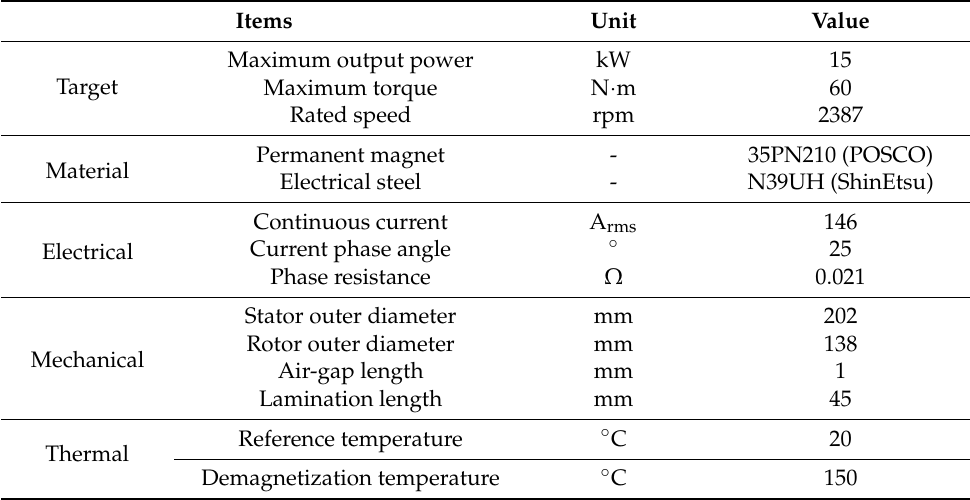
Figure 1. Shape of the initial model. Table 1. Specifications of the initial model.